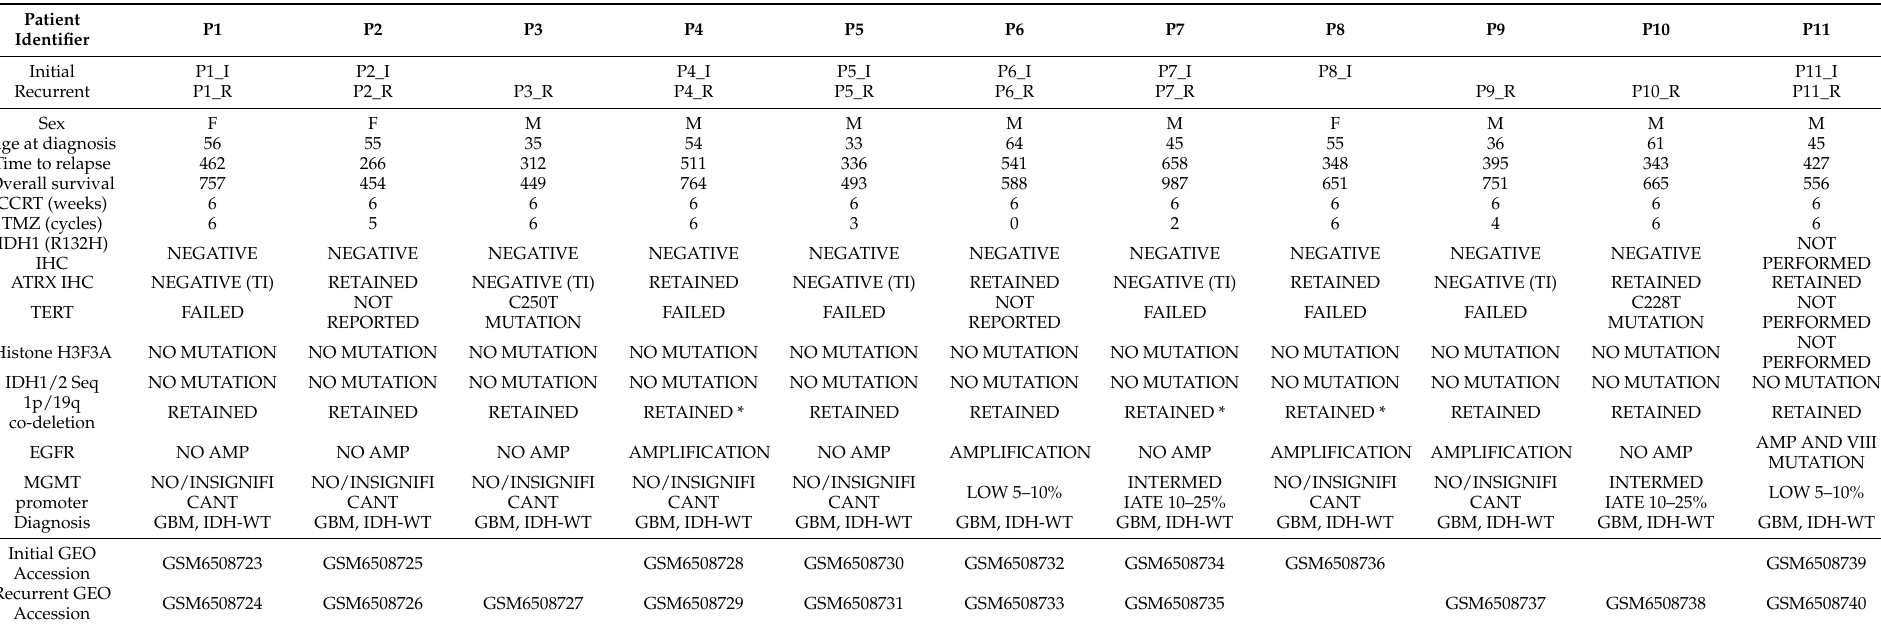
Table 1. A summary of relevant clinical, treatment, molecular profiling, and diagnosis data for the GBM IDH-wildtype patients assessed. Time to relapse and overall survival are measured in days. The data file accession numbers for the initial and recurrent tumors are provided. TI = Technical Issue, TU =